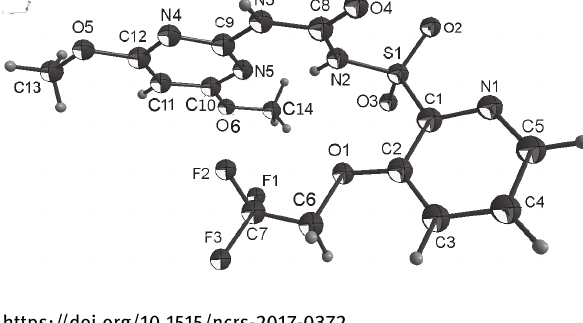
Table 2: Fractional atomic coordinates and isotropic or